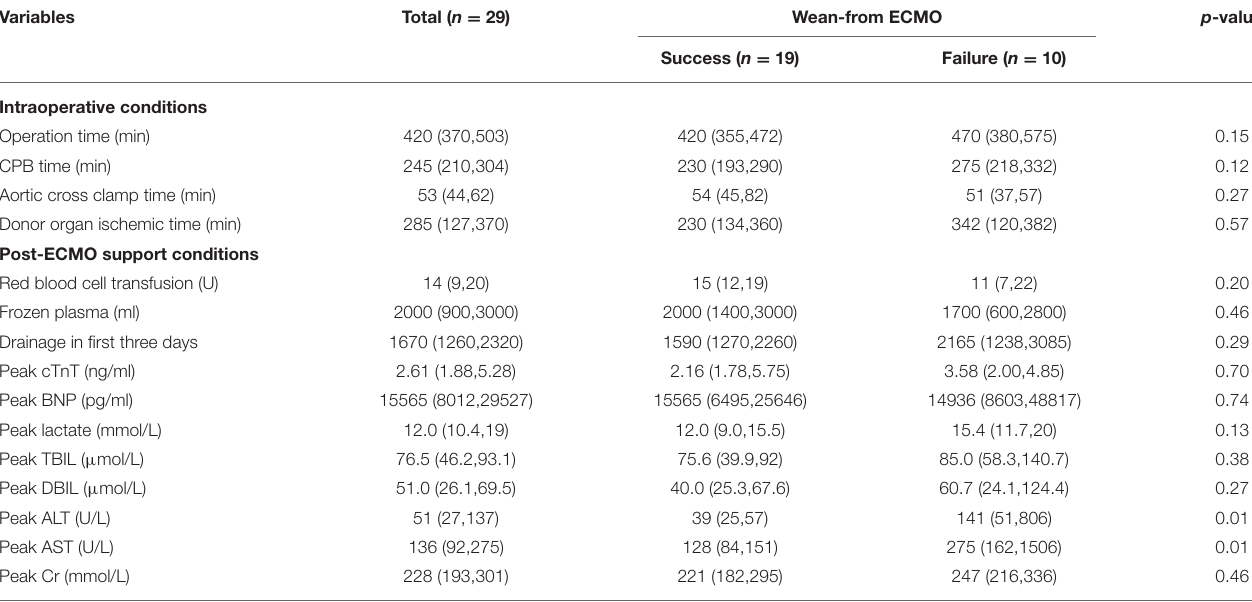
TABLE 2 | Intraoperative and postoperative clinical characteristics.